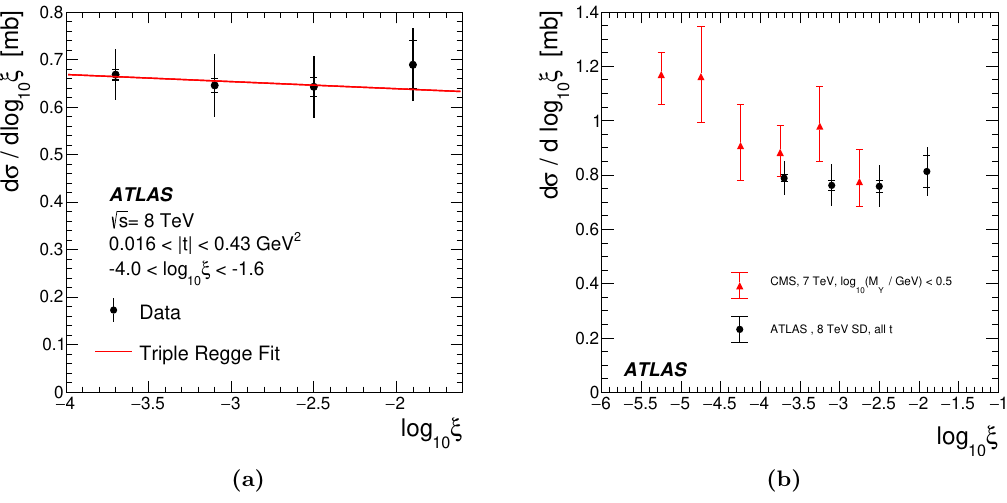
Figure 5. The di(cid:11)erential cross section as a function of log (cid:24) . (a) Data in the (cid:12)ducial t range, 10 compared with the results of the triple Regge (cid:12)t described in the text. (b) ATLAS data extrapolated to the full t range, compared with a rapidity-gap-based CMS measurement [15] that contains a small DD admixture (see text). The inner error bars represent only statistical uncertainties while the outer error bars display the combination of statistical and systematic uncertainties in